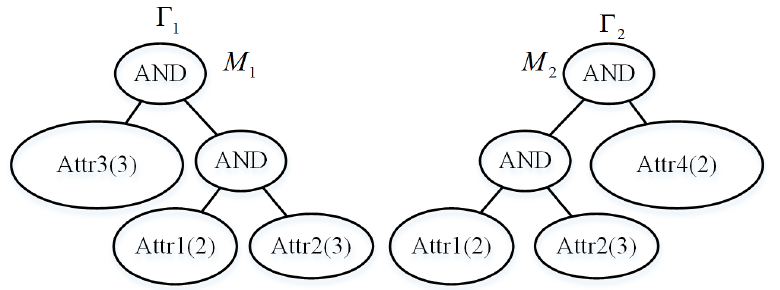
Figure 1. Two data providers have data M 1 and M 2 to share separately. Γ 1 and Γ 2 are the weighted access policies of M 1 and M 2